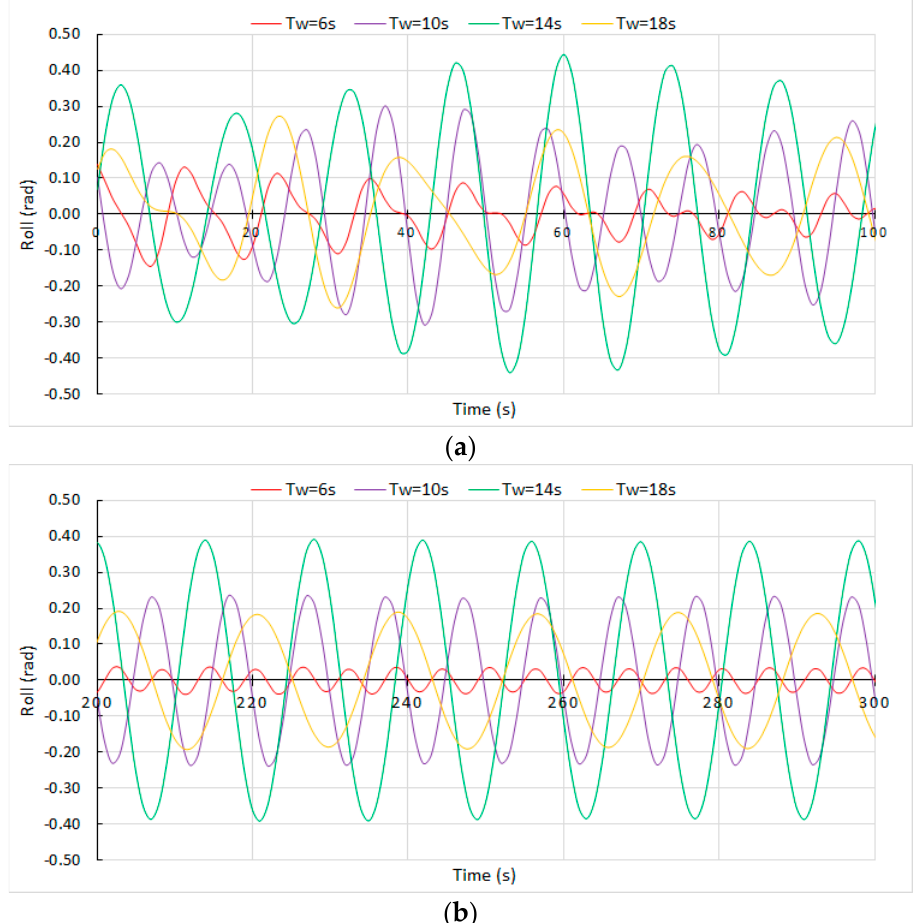
Figure 14. Rolling angles reached with different sea state conditions for Td = 12 s, ( a ) from 0 to 100 s and ( b ) from 200 s to 300 s.